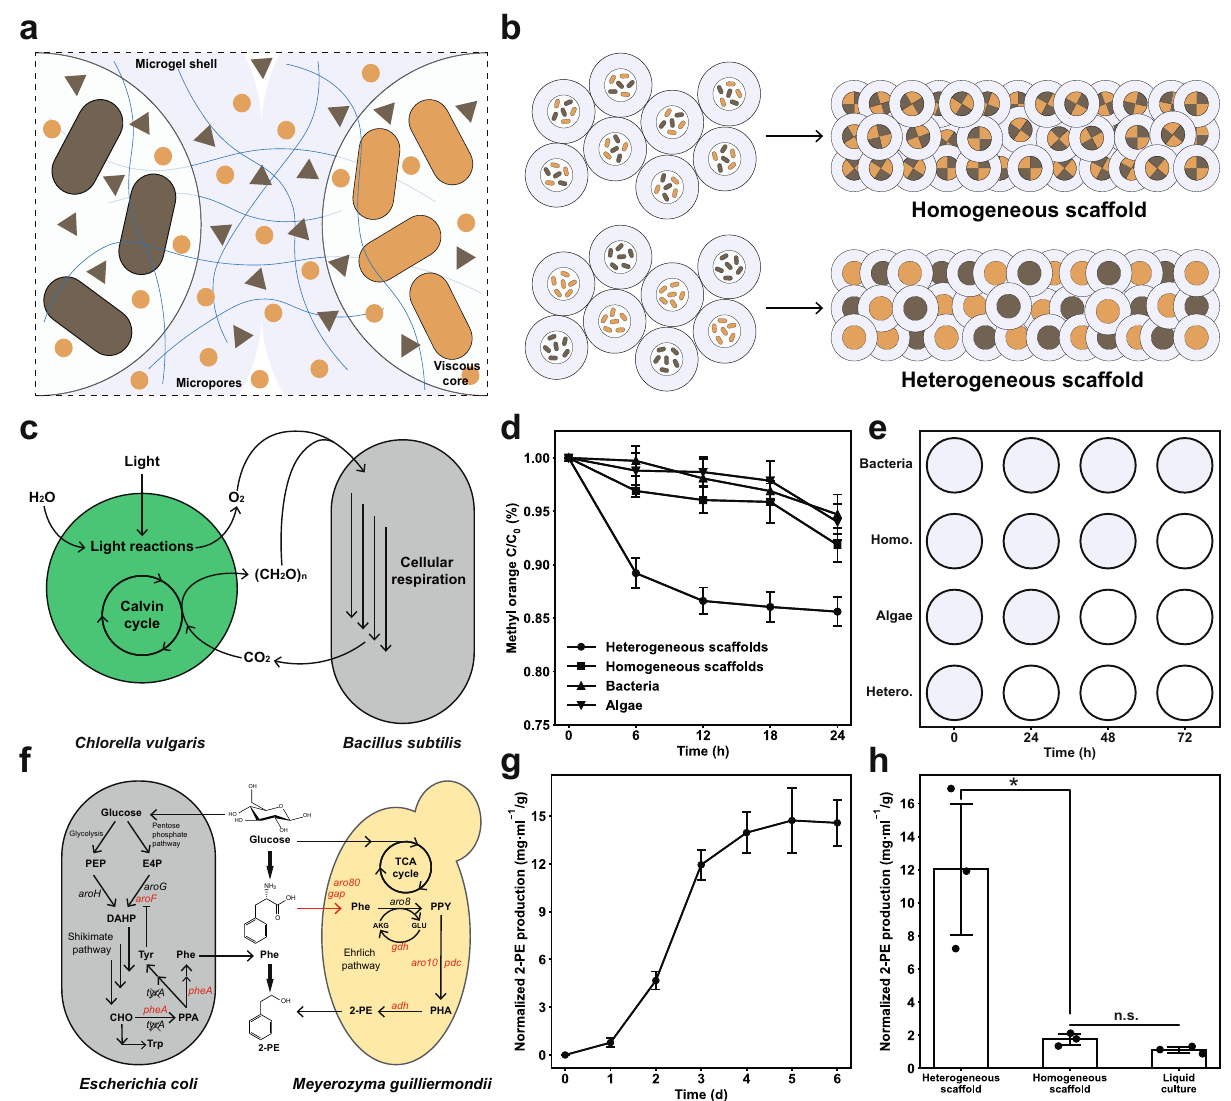
Fig. 5 | Miscroscopic compartmentalziation enhances bioactivities of micro- bial consortia. a PAM scaffolds immobolize and segregate microbial consortia at microscopic space, which prevents competetive growth while enabling a more ef fi cient mass transfer of metabolites between speceis. Circles and triangles represent metabolites secreted by microbes. b Cell-laden core-shell microgels are jammed and printed into scaffolds. Heterogeneous and homogeneous scaffolds are de fi ned as: a mixed population of microgels containing two different micro- organism species, respectively, and a homogeneous population of microgels containing a mixtureoftwo microorganisms. c – e A mutualism modelof microbial consortia. c Schematic representation of the relationship between Chlorella vul- garis and Bacillus subtilis . d Bioremediation of methyl orange by heterogeneous scaffolds, homogeneous scaffolds, and scaffolds immobilizing monocultures of microalgae and bacteria, respectively, n =3 independent biological experiments. e Characterizationof scaffold disintegrationin72hours.Theclosed symbolmarks an unbroken scaffold whereas open symbol scaffold markedly disintegrating. For